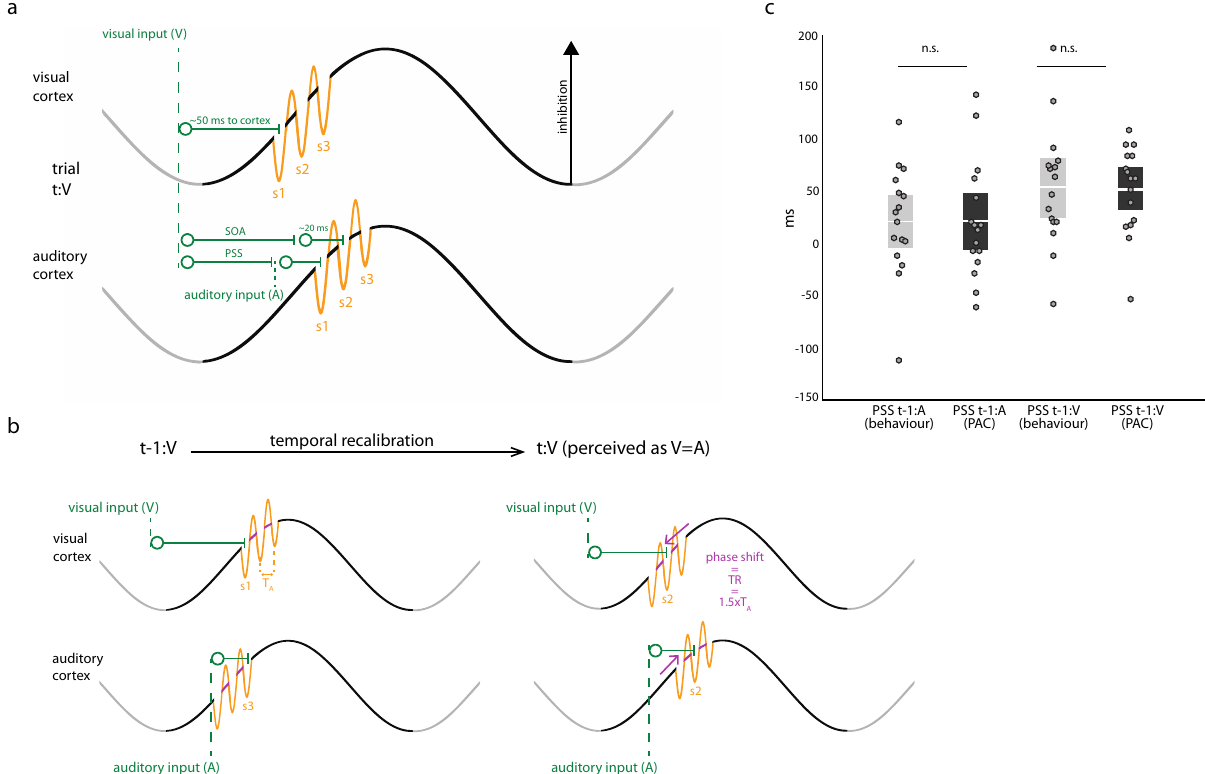
Fig. 7 Dynamic-insertion mechanism of rapid temporal recalibration. a Cortical registration of sensory inputs. Schematic illustration of slow oscillatory variations in auditory and visual cortices marking the level of net regional inhibition. PAC manifests as faster oscillatory cycles (orange) nested within slower-frequency cycles. The Dynamic-insertion model posits that each alternation of the fast oscillation de fi nes a sensory registration “ slot ” (marked as s1, s2, and s3) that transiently reduces inhibition to facilitate the cortical registration of the sensory input. Here we consider the example of a multimodal stimulus pair consisting of a visual sensory input (V, occurrence marked with fi rst green vertical dashed line to the left) preceding an auditory sensory input (A; rightmost vertical dashed line). The trial (t) is labeled t:V to indicate the sequence (V preceding A) of sensory inputs in the pair. The visual neural signal takes about 50 ms to reach the cortex from the retina. The time latency of the auditory stimulus with respect to the visual presentation is the SOA. Neural signals reach the auditory cortex within a considerably shorter amount of time than along visual pathways (~20 ms vs. 50 ms). When the SOA is long enough, the stimulus pair is perceived as asynchronous because the visual cortical input is registered in slot s1 in visual cortex, while the auditory input is registered in slot s2 in auditory cortex. When the SOA is shorter and reaches the PSS, both the auditory and the visual neural signals are registered in the s1 slots of the respective sensory cortices and the stimulus pair is perceived as synchronous. b Dynamic-insertion mechanism of rapid temporal recalibration (TR). We denote T A the period of the fA cycle. In the example shown, the preceding trial (left) is of the t-1:V type, whereby the visual input precedes the auditory input. (Note that the model also applies to t-1:A trials.) In this t-1:V trial the SOA is such that the visual input is registered to a s1 slot and the auditory input to a s3 slot resulting in an asynchronous perception of the audiovisual stimulus pair. The Dynamic-insertion model predicts that during rapid temporal recalibration the phase occurrence of fA oscillatory segments along the slow cycles in the auditory and visual cortex is shifted to adapt to the current audiovisual modality order. The subsequent effect of this phase shift (highlighted with pink arrows) is that on the current trial (for illustration purposes t:V with similar SOA to trial t-1:V) both the auditory and visual stimuli are more likely to be registered to a s2 slot. The resulting subjective perception of the stimulus pair is more synchronous than on the previous trial. The audiovisual asynchrony on trial t-1 causes a shift in PSS, such that similar asynchronies on trial t appear less pronounced than before (as seen in behavioral data in Fig. 2b). c Empirical & PAC model of point of subjective simultaneity (PSS). The PSS values derived from the Dynamic-insertion model predictions (black bars) were statistically identical on average to those observed empirically in participants (gray bars), in both conditions (t-1:A, left; and t-1:V, right) with p = 0.95 and p = 0.92, respectively (two-sampled paired t tests). Dots represent single-subject data ( n =